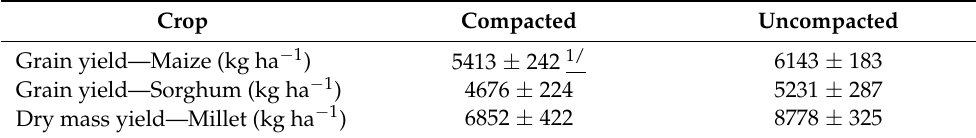
Table 1. Yields of maize, sorghum, and millet in compacted and uncompacted soils. Crop